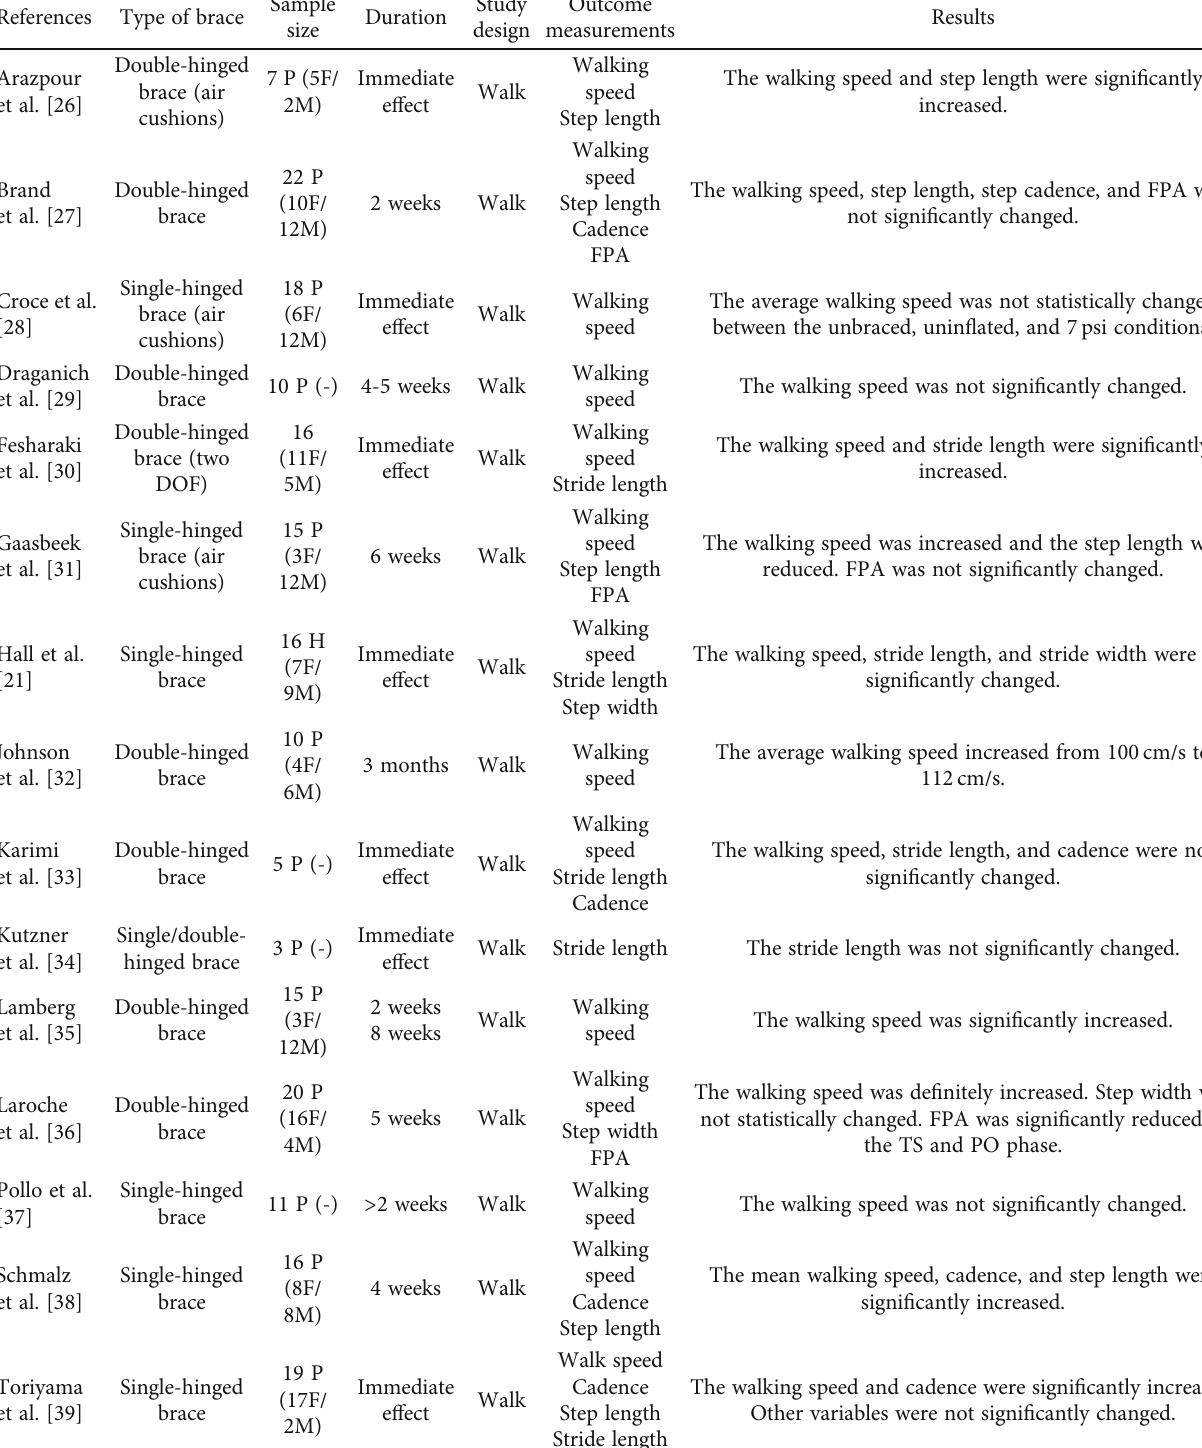
Table 1: Studies that evaluated the e ff ect of knee brace on spatiotemporal parameters in medial gonarthrosis.